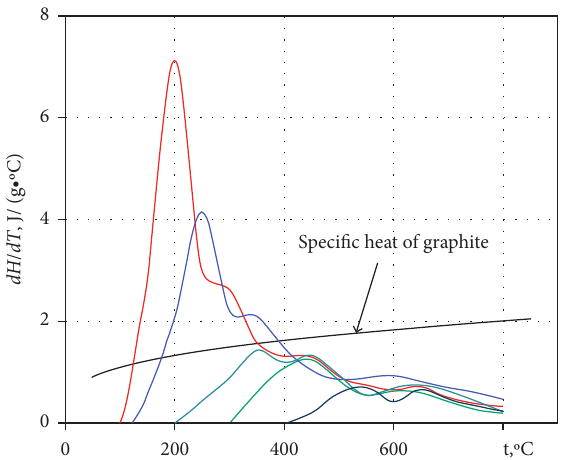
Figure 5: Spectra of the release of stored energy in irradiated graphite removed from storage